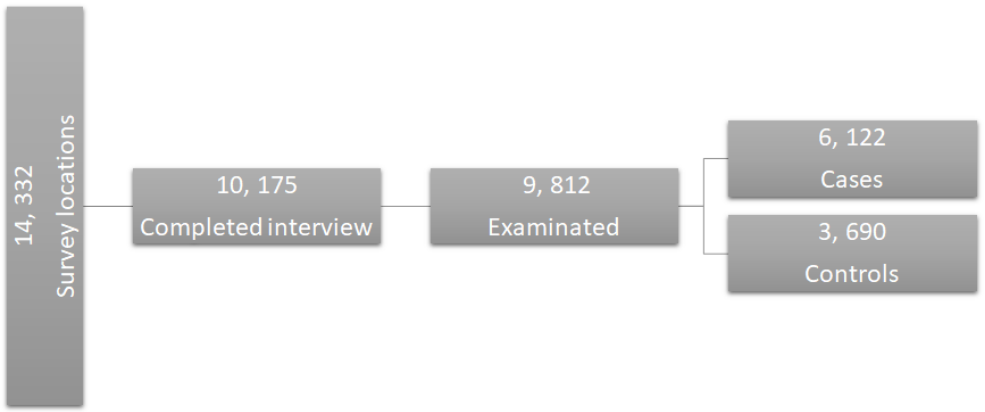
Figure 2. Subject selection